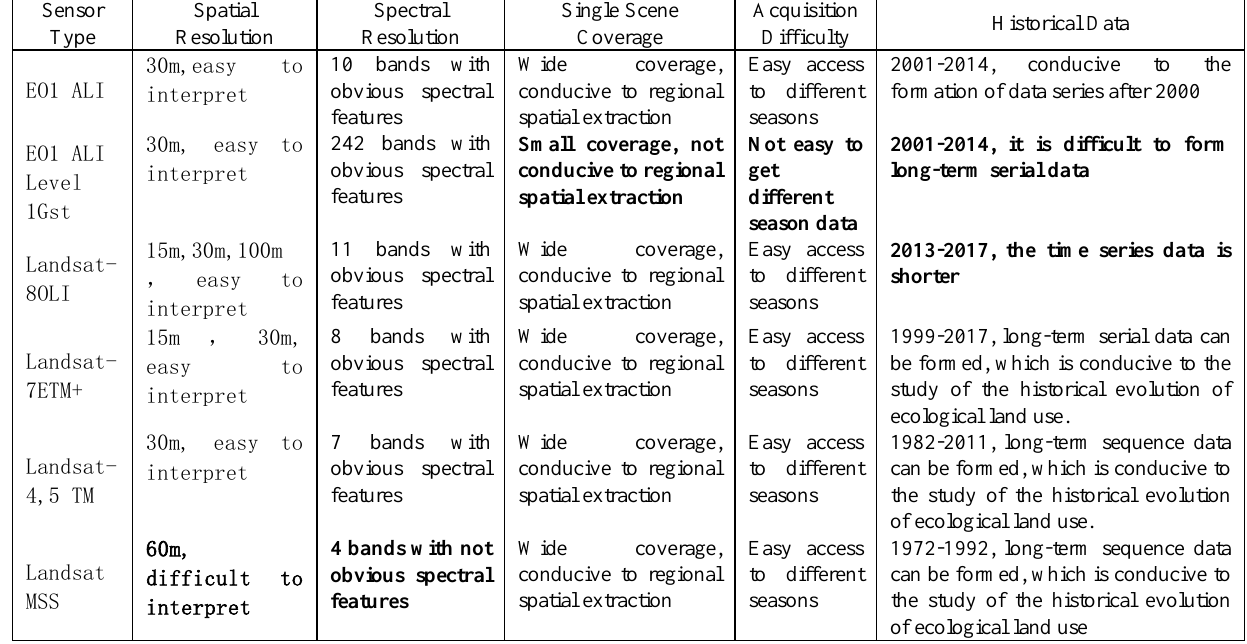
Table 2 The pros and cons of various types of sensor